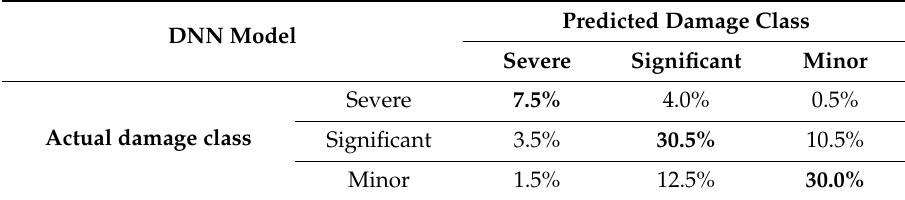
Figure 11. Scatter plots of maximum accuracies with epochs from 30 test results for each model: ( a ) all models; ( b ) DNN-based model; ( c ) CNN-based model; ( d ) RNN-based model. Table 4. Example of confusion matrix for the DNN model.